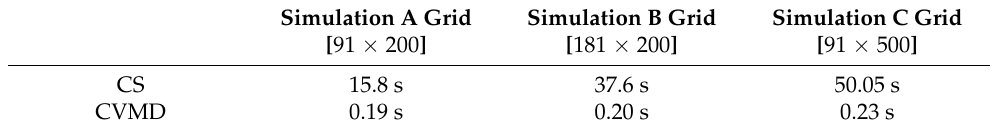
Table 1. Comparison of the computing